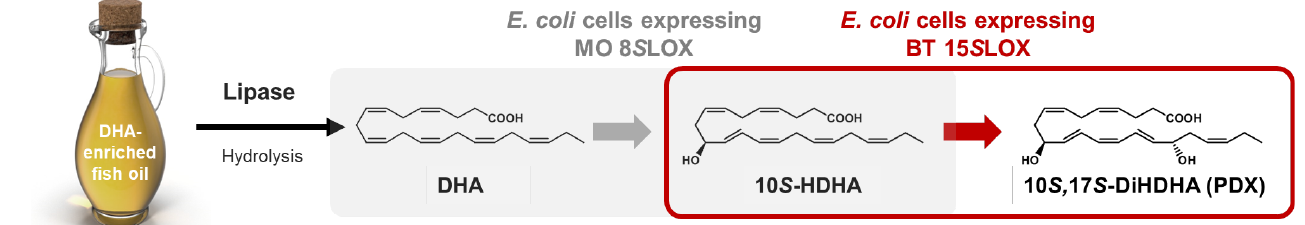
Figure 1. Biosynthetic pathway of 10 S ,17 S -DiHDHA (PDX) from DHA-enriched fish oil. DHA, which is hydrolyzed from DHA-enriched fish oil by lipase, is converted to PDX via 10 S -HDHA by mouse 8 S -LOX and BT 15 S -LOX.